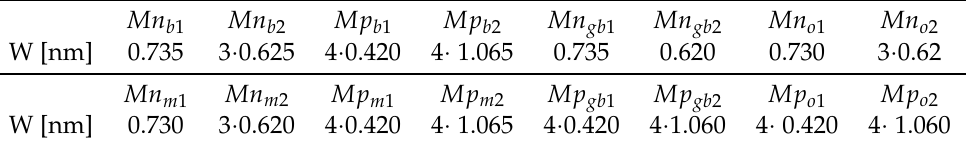
Table 1. Transistors’